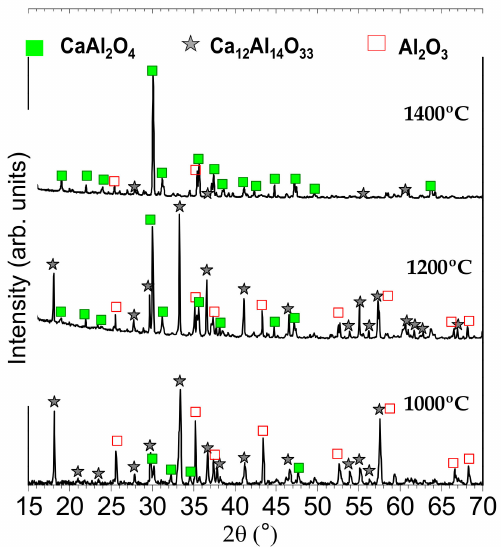
Figure 2. X-ray di ff ractograms of synthesized CAO: Eu, Nd phosphors heated at 1000, 1200 and 1400 ◦ C for 2 h in 90N 2 -10H 2 , employing a salt / CAO molar ratio of 3:1. The symbols highlight Al 2 O 3 (red-open squares), CaAl 2 O 4 (green squares) and Ca 12 Al 14 O 33 (gray